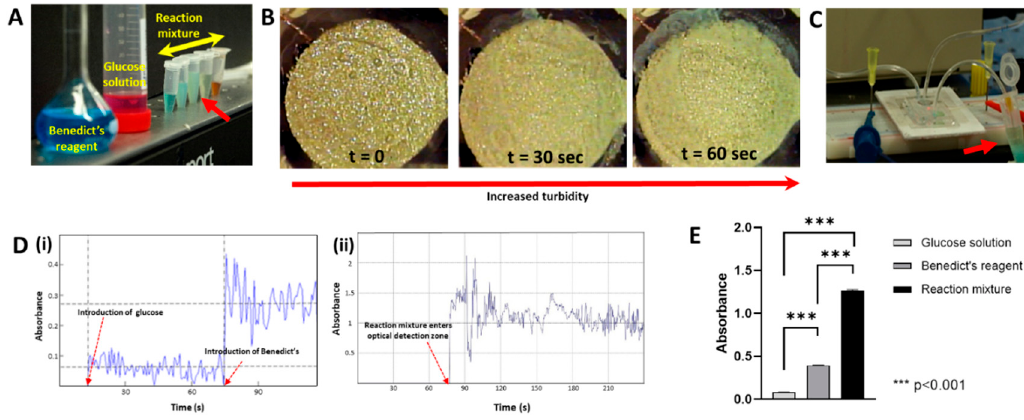
Figure 4. Implementation of Benedict’s reaction inside the optical microfluidic device for colorimetric detection of glucose in the presence of cell culture media. ( A ) Change in the color of the specimens for various concentrations of the glucose solutions, with the diluted samples showing shades of blue color. Reaction mixture upon heating turned to brick red color as expected. Arrow indicates the color obtained with undiluted glucose. ( B ) Variation, at different time points, in the turbidity of the reacting fluids (glucose solution and Benedict’s solution) upon piezo actuated mixing inside the microfluidic channel. ( C ) Reaction mixture ejected out of the microfluidic channel, indicating the same coloration as indicated in panel-A. ( D ) Real-time absorbance measurements at 635 nm wavelength of (i) glucose solution and the Benedict’s reagent and (ii) Reaction mixture upon entering the optical detection zone. ( E ) Comparison of the optical absorption values of the working fluids. The reaction mixture shows a significantly higher absorbance ( p < 0.001) than both the glucose solution and the Benedict’s solution, due to the turbidity created upon mixing, thereby validating the colorimetric detection principle.